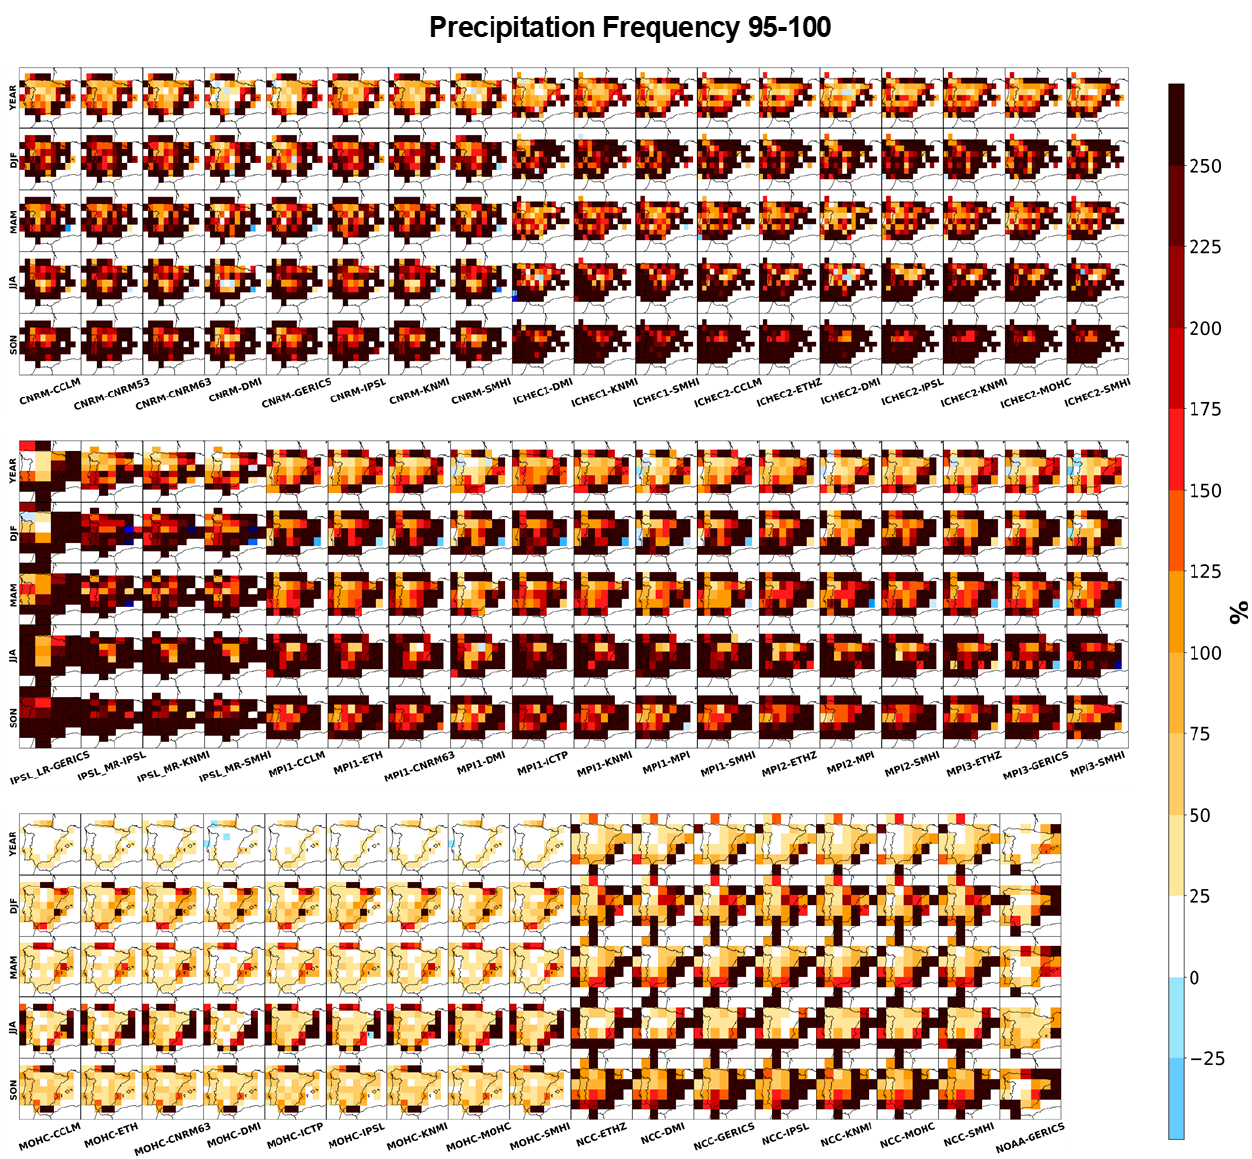
Figure 8. Yearly and seasonal distribution added values (DAVs) of the Iberian Peninsula for the historical (1971–2005) EURO-CORDEX RCMs, with the IGD as a reference for the daily precipitation frequency, only considering the values above the observational 95th percentile. All RCM data were previously interpolated to 0.1 ◦ regular resolution from the observations, while the observations were interpolated into each CMI5 GCM